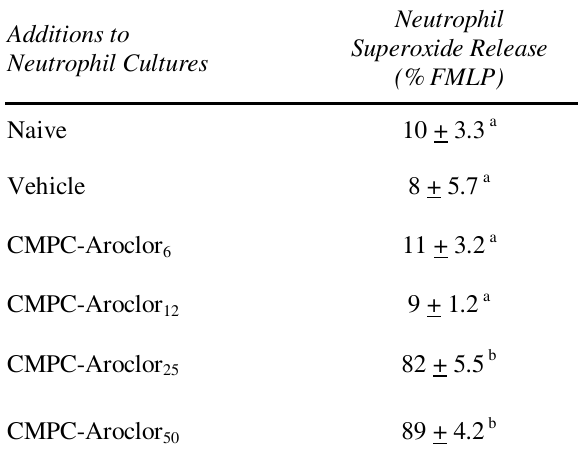
Table 6: Induction of Neutrophil-Derived Super Oxide Release by Conditioned Medium from PC Treated with Aroclor. Isolated neurophils (2 X 10 6 cells/mL) were or vehicle incubated with CMPC-Aroclor (6, 12, 25 or 50 µM) for 24 hrs. After this incubation, neutrophil-derived sueroxide production was analyzed using cytochrome C